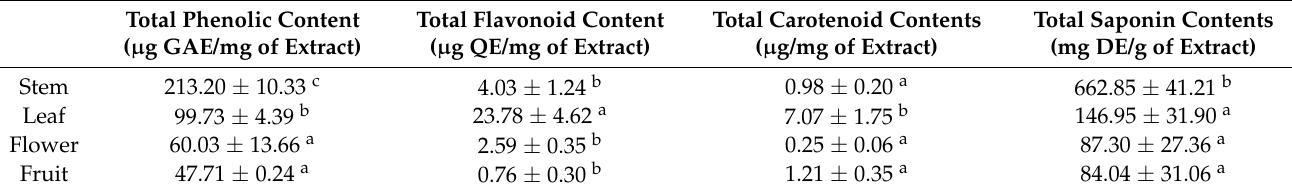
Table 1. Phytochemical contents in R . rugosa organ